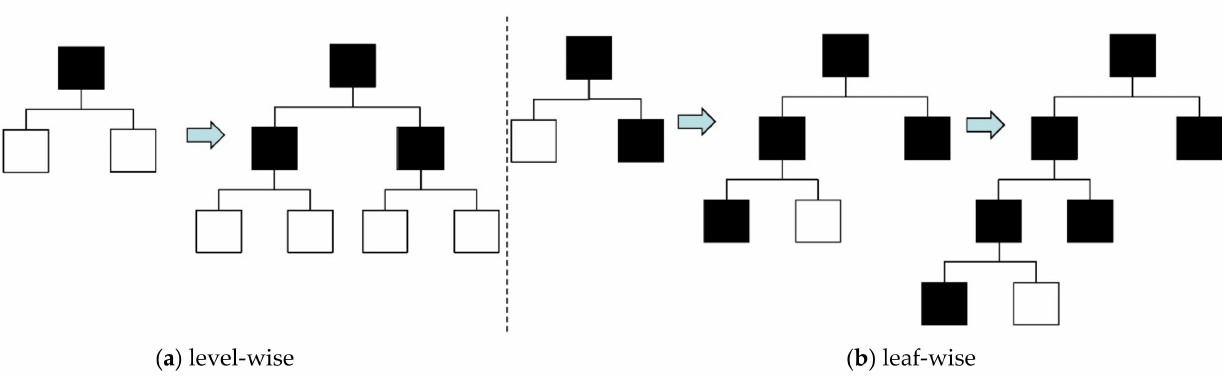
Figure 9. The diagram of the leaf-wise ( a , b ) tree growth strategy with a depth